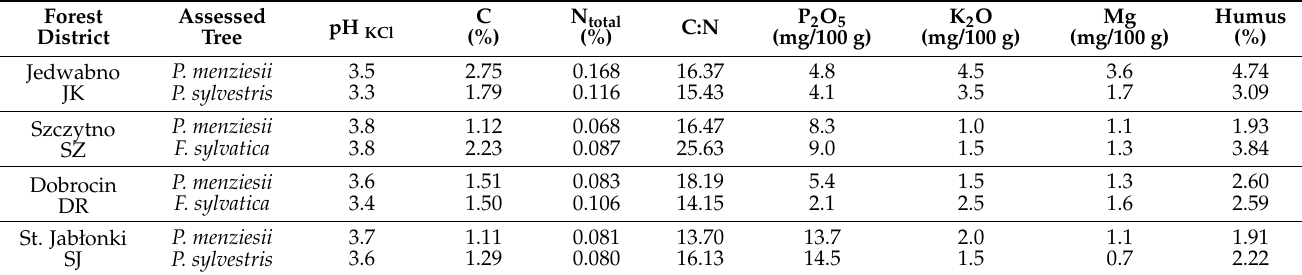
Table 2. Values of some soil properties in samples around particular trees.